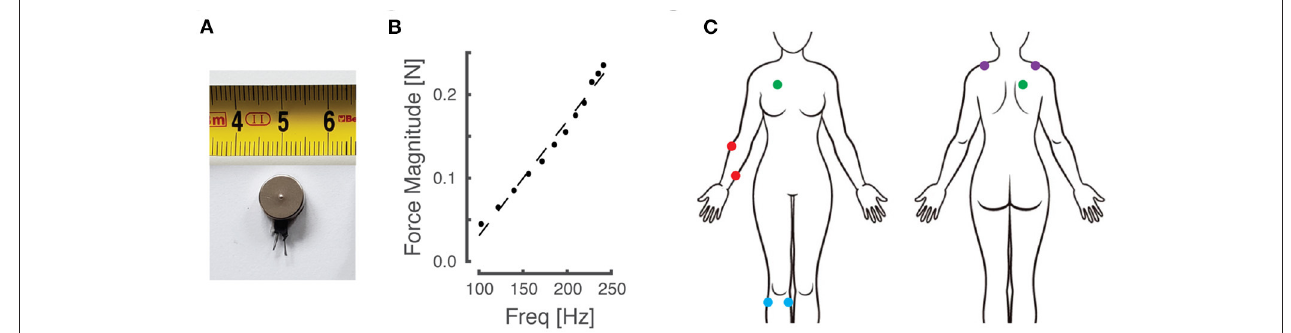
FIGURE 1 | Materials and experimental setup. (A) An example of the eccentric rotating mass (ERM) vibration motors used for this study. (B) Empirical relationship between vibration frequency and magnitude, which co-vary monotonically as a function of motor activation in the ERM motors used in this study. (C) Schematic of the body with vibration motor locations indicated by colored dots. Red: right forearm; purple: right/left shoulders; blue: right knee; green: right torso.